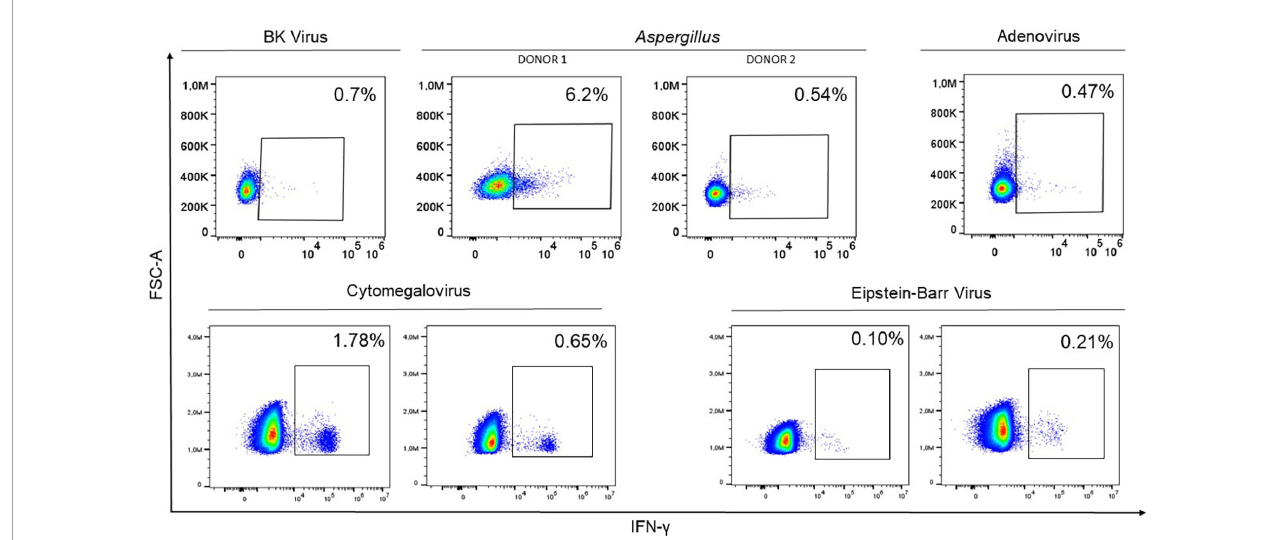
FIGURE2 Representation of interferon-gamma (IFN- γ ) expression by flow cytometry in 8 potential donors within the CD45RA − subpopulation after co-culturing peripheral blood mononuclear cells with the mixture of 4 BKV peptides (ST, LT, VP1, VP2), Aspergillus fumigatus Lysate at a final concentration of 1 µ g/ml for Aspergillus ; PepTivator R (cid:13) AdV Select for Adenovirus; PepTivator R (cid:13) CMV pp65 for HCMV; and EBV-PT consensus premium grade human for EBV. In all cases, the cell response was sufficient for use in cell therapy. Donor apheresis was therefore performed, and CD45RA − T cells were isolated and infused.